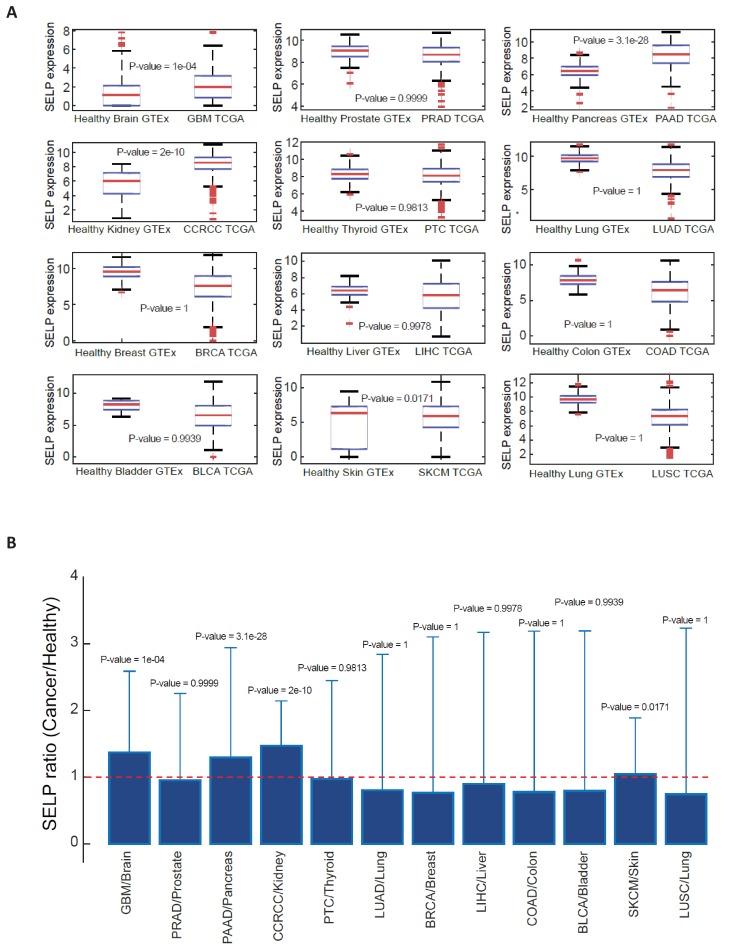
SELP expression in healthy and cancerous tissues.Data was obtained from XENA database (http://xena.ucsc.edu/public-hubs/), which normalizes gene expression from TCGA and GTEx together. (A) For each tissue type, the distribution of SELP gene in healthy versus cancerous tissue was compared via a Wilcoxon one-sided rank sum test, and the boxplots are presenting the distribution of SELP in each tissue. (B) The bar plots are showing the ratio of mean expression in cancerous vs. healthy in each tissue type, and the error bars represent the standard deviation over all sample points.